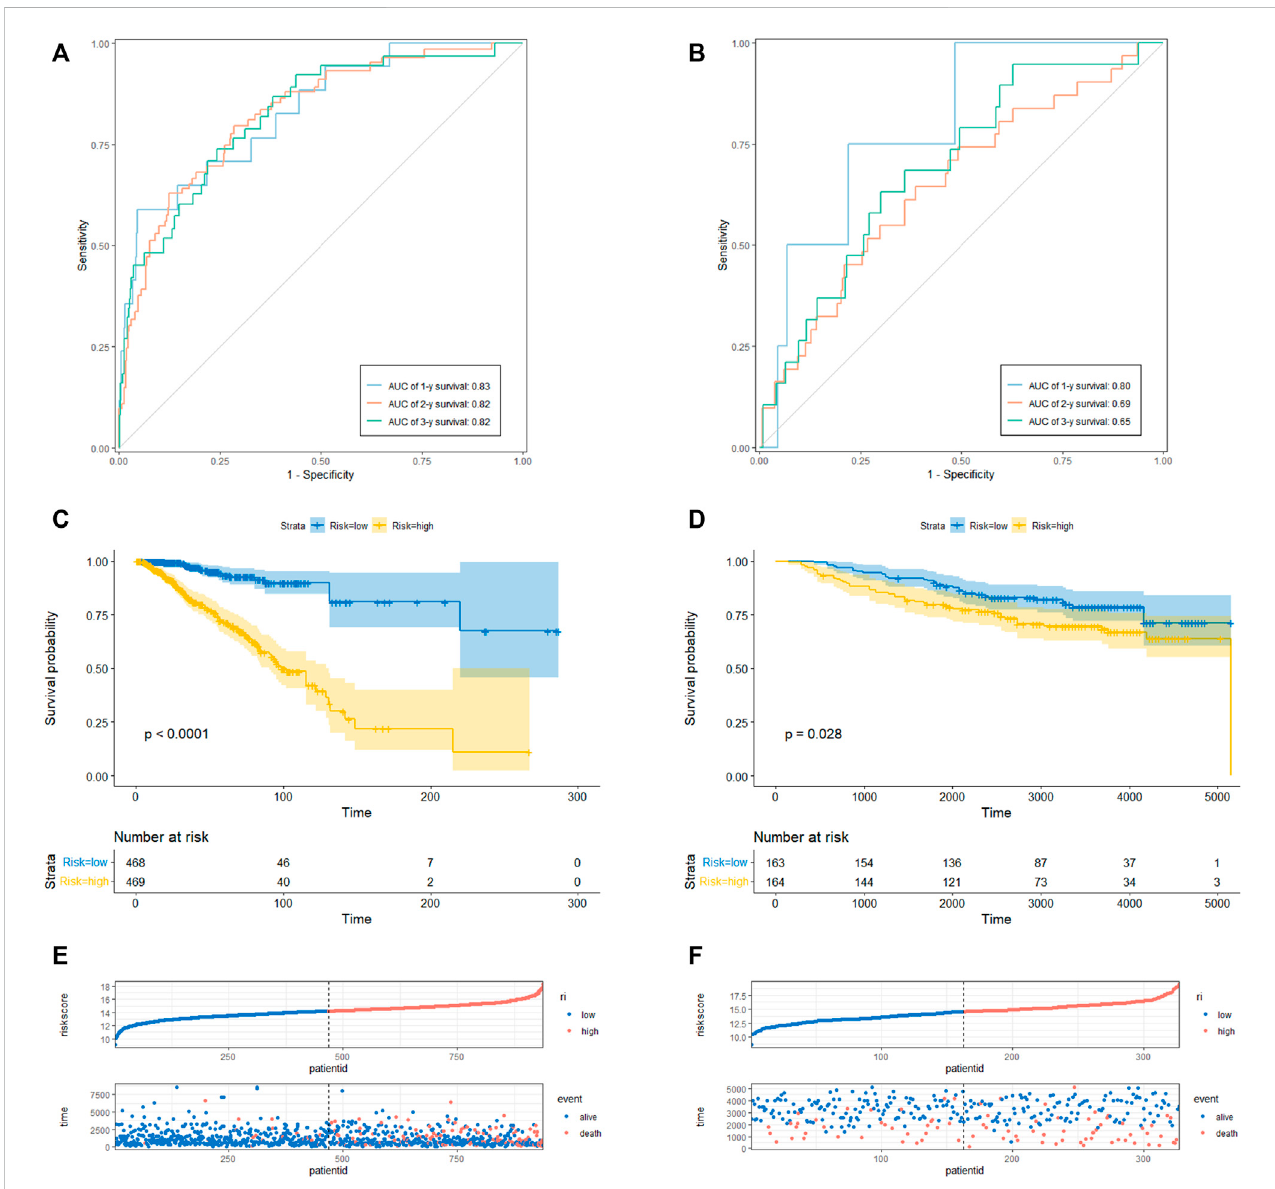
FIGURE 3 CRRGs signature associated with BC patient ’ s overall survival (OS). (A) The predictive value for the 1-y, 2-y and 3-y OS in TCGA-BRCA dataset. (B) The predictive value for the 1-y, 2-y and 3-y OS in GSE20685 dataset. (C) The OS between the CRRGs high- and low-risk groups in TCGA-BRCA dataset. (D) The OSbetweentheCRRGshigh-andlow-riskgroupsinGSE20685dataset. (E) TheriskplotoftheCRRGssignatureinTCGA-BRCAdataset. (F) Theriskplotofthe CRRGs signature in GSE20685